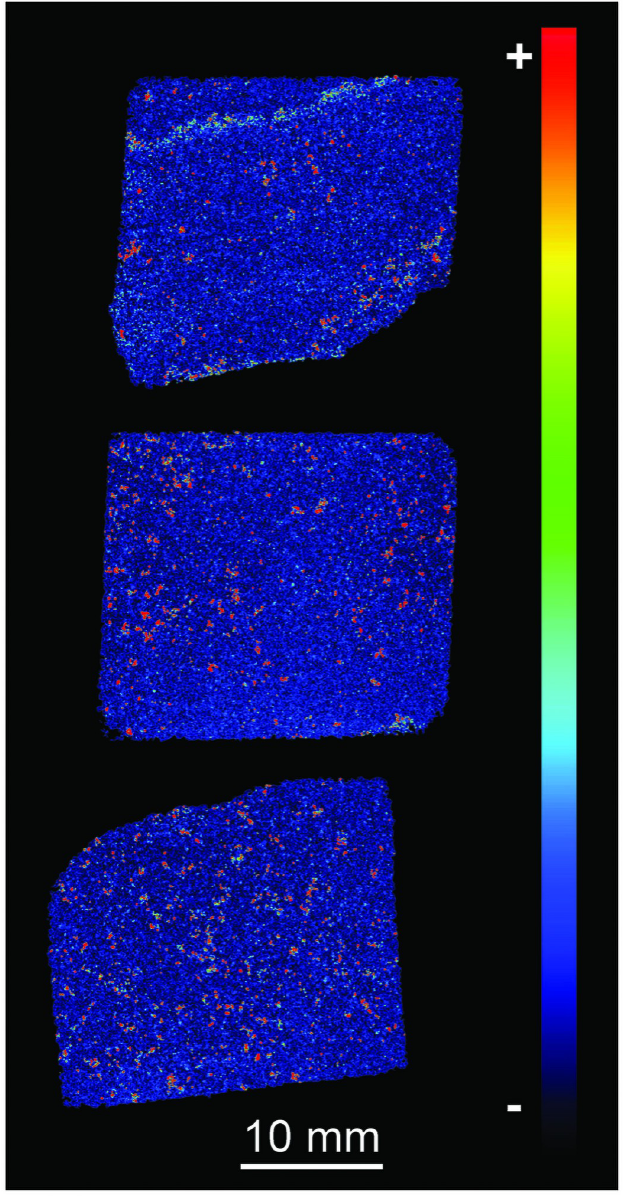
Fig 18. μ XRF heatmap of the relative intensity of Fe in thin sections SH1B (bottom), SH2B (middle) and SH3B (top) from the Phillips’ Core (from Stone 58 at Stonehenge). Red colours indicate higher and blue colours lower relative Fe